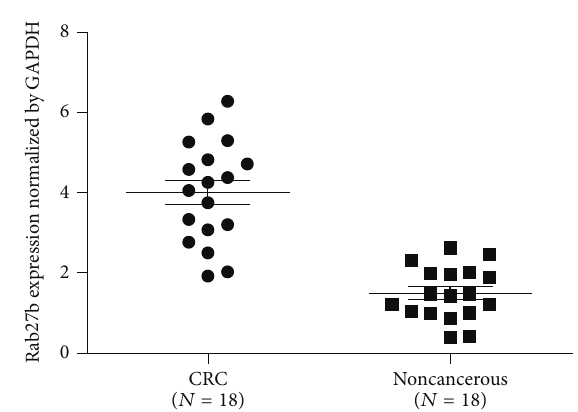
Figure1:One-stepquantitativereal-timepolymerasechainreaction (qPCR) was employed to evaluate Rab27b mRNA expression levels in 18 colorectal cancer (CRC) tissues compared with matched non- cancerous tissues. When normalized to glyceraldehyde 3-phosphate dehydrogenase (GAPDH) mRNA levels, the Rab27b mRNA level in CRC tissues (4.01 ± 0.301) is significantly higher than that in corresponding noncancerous tissues (1.50 ±